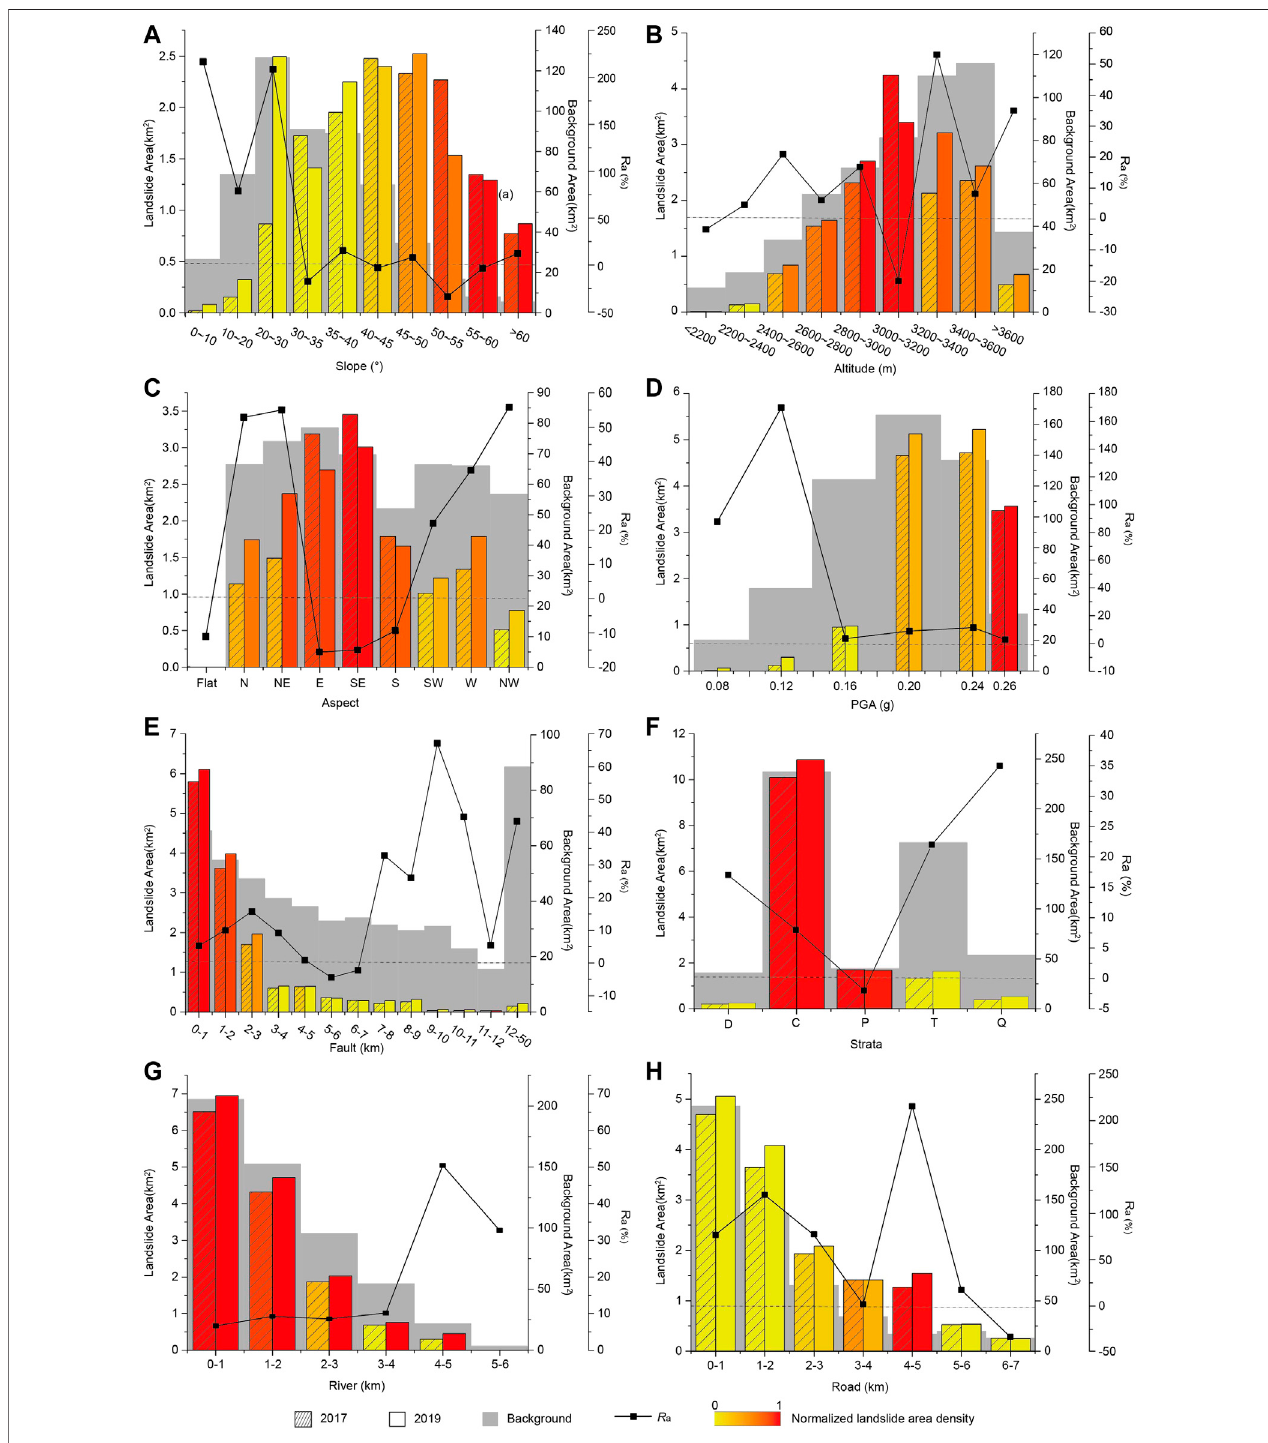
FIGURE 12 | Distribution of coseismic landslides and post-seismic landslide change (A) Slope (B) Altitude (C) Aspect (D) PGA (E) Distance to fault (F) Strata (G) Distance to rivers (H) Distance to roads.